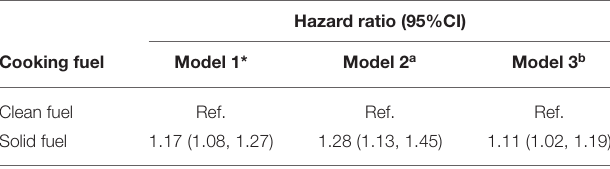
TABLE 4 | Sensitivity analyses for the association of cooking fuels with 8-year